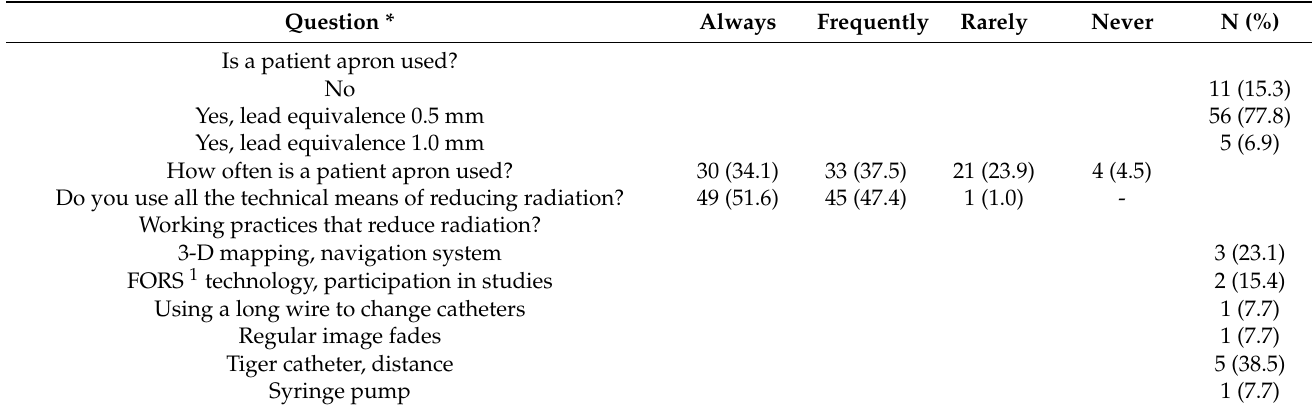
Table 4. Information provided by study participants on other means of reducing radiation.